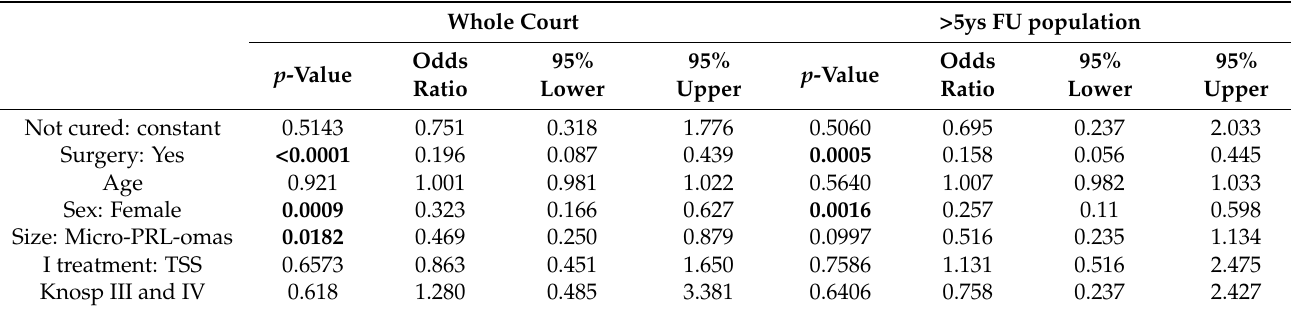
Table 4. Rate of a cure depending on the first-line treatment and surgery in the whole cohort; considering the whole court of patients, surgery ( p < 0.0001), female sex ( p < 0.0009), and size ( p < 0.0182) strongly impacted the cure rate; surgery ( p < 0.0005) and female sex ( p < 0.0016) were confirmed significative for the subgroup with a follow-up >5